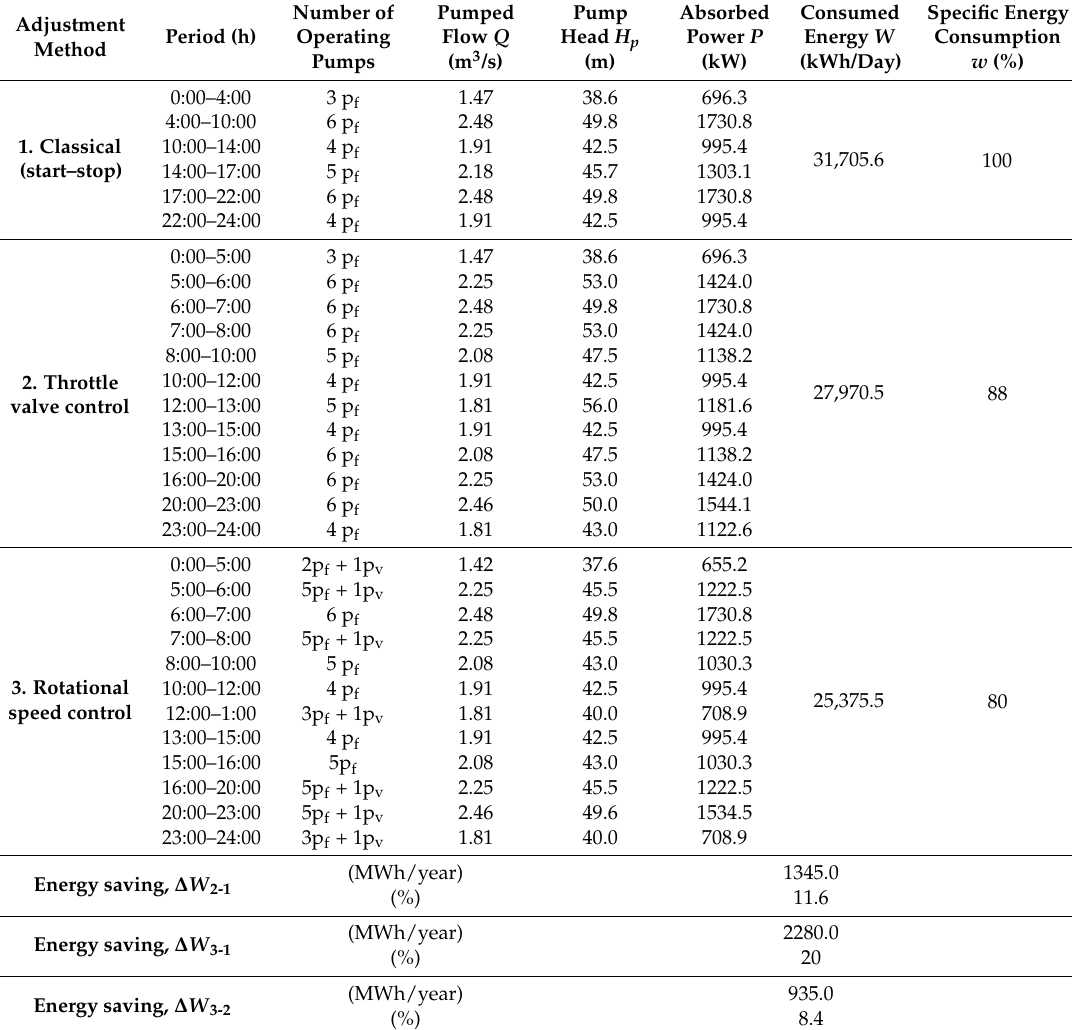
Table 1. The specific energy consumption and energy savings obtained with control